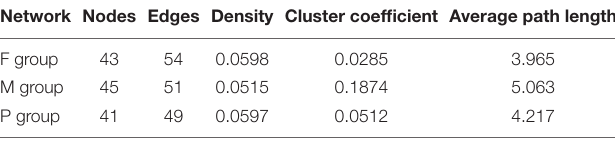
TABLE 4 | Distributions of predominant bacteria at different taxonomic levels. TABLE 5 | Topological properties of the network in three